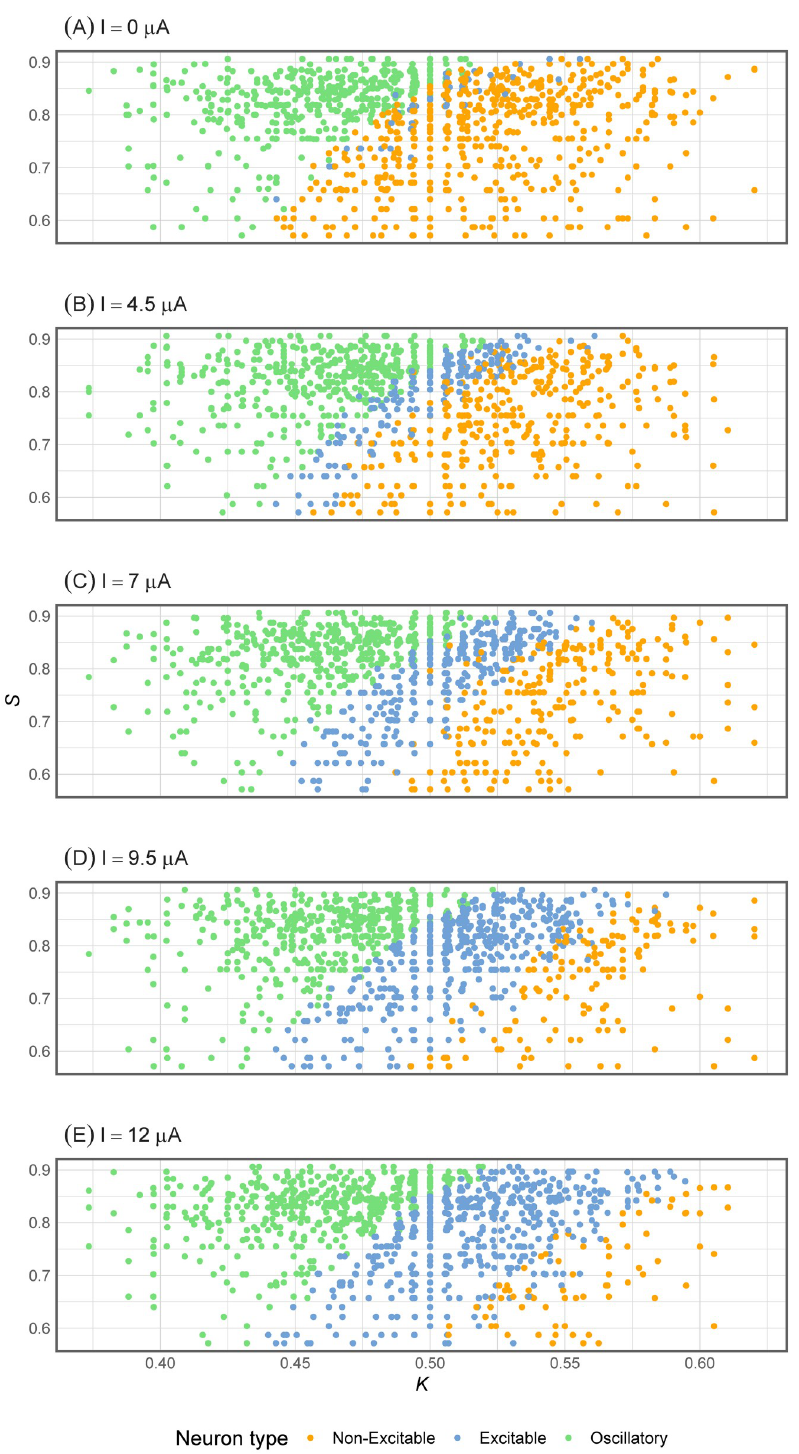
Fig 2. ( S ; K ) values by stimulus amplitude and neuron type.